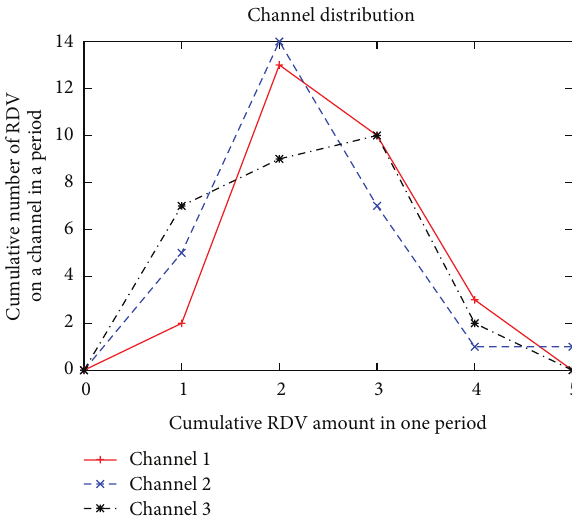
Figure 9: Asymmetric channel set: combination of maps with 3 and 4